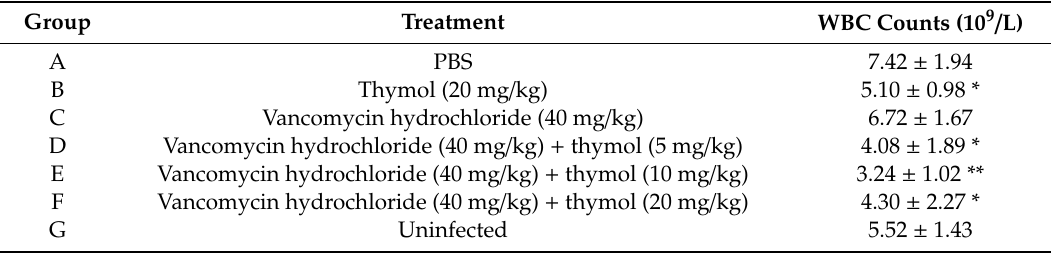
Table 1. White Blood Cell (WBC) counts in mice in response to di ff erent treatments.